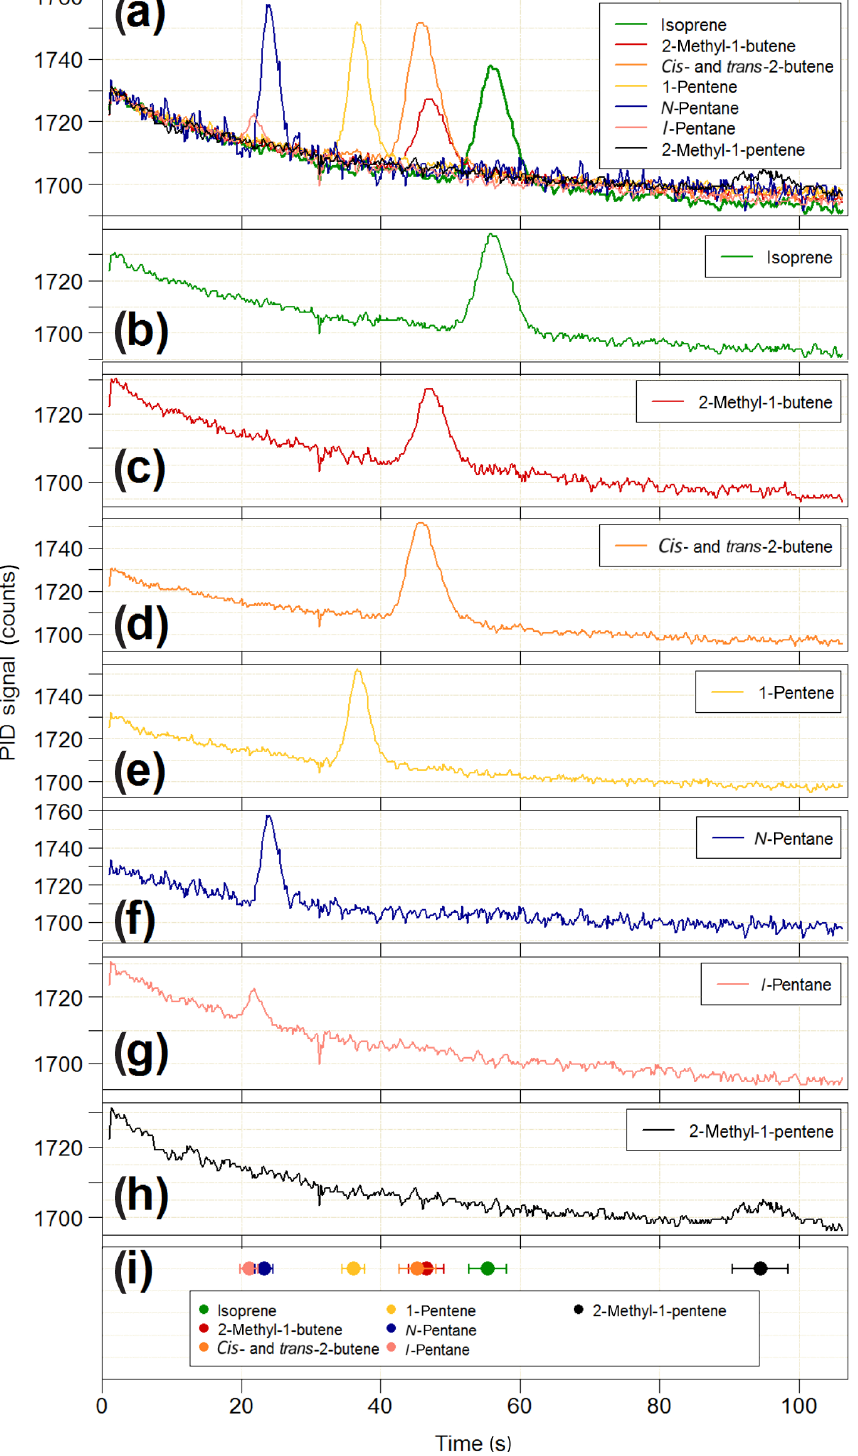
Figure 12. Results of the co-elution tests on the iDirac. (a) Overlaid chromatograms of isoprene (green line) and six potential interfering species: 2-methyl-1-butene (red line), cis - and trans -2-butene (orange line), 1-pentene (yellow line), n -pentane (blue line), i -pentane (pink line) and 2-methyl-1-pentene (black line). The chromatograms of each individual species are shown in panels (b–h) . The co-elution tests are summarised in panel (h) , where the elution time of each species (filled circles) is plotted along with its peak width (FWHM) to assess peak